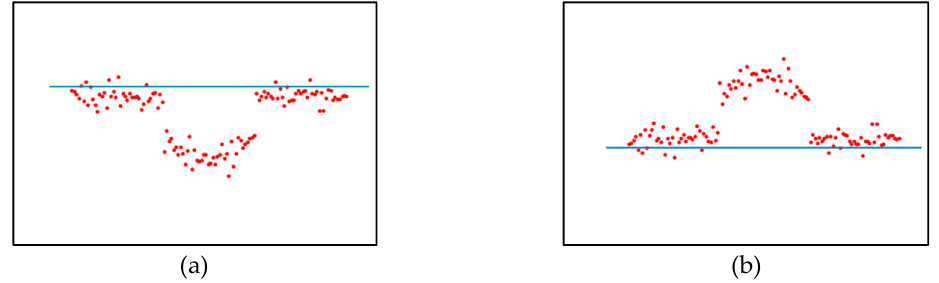
Figure 10. Schematic diagram of ( a ) road cavity and ( b ) road bulge. Both deviate from the local fitting